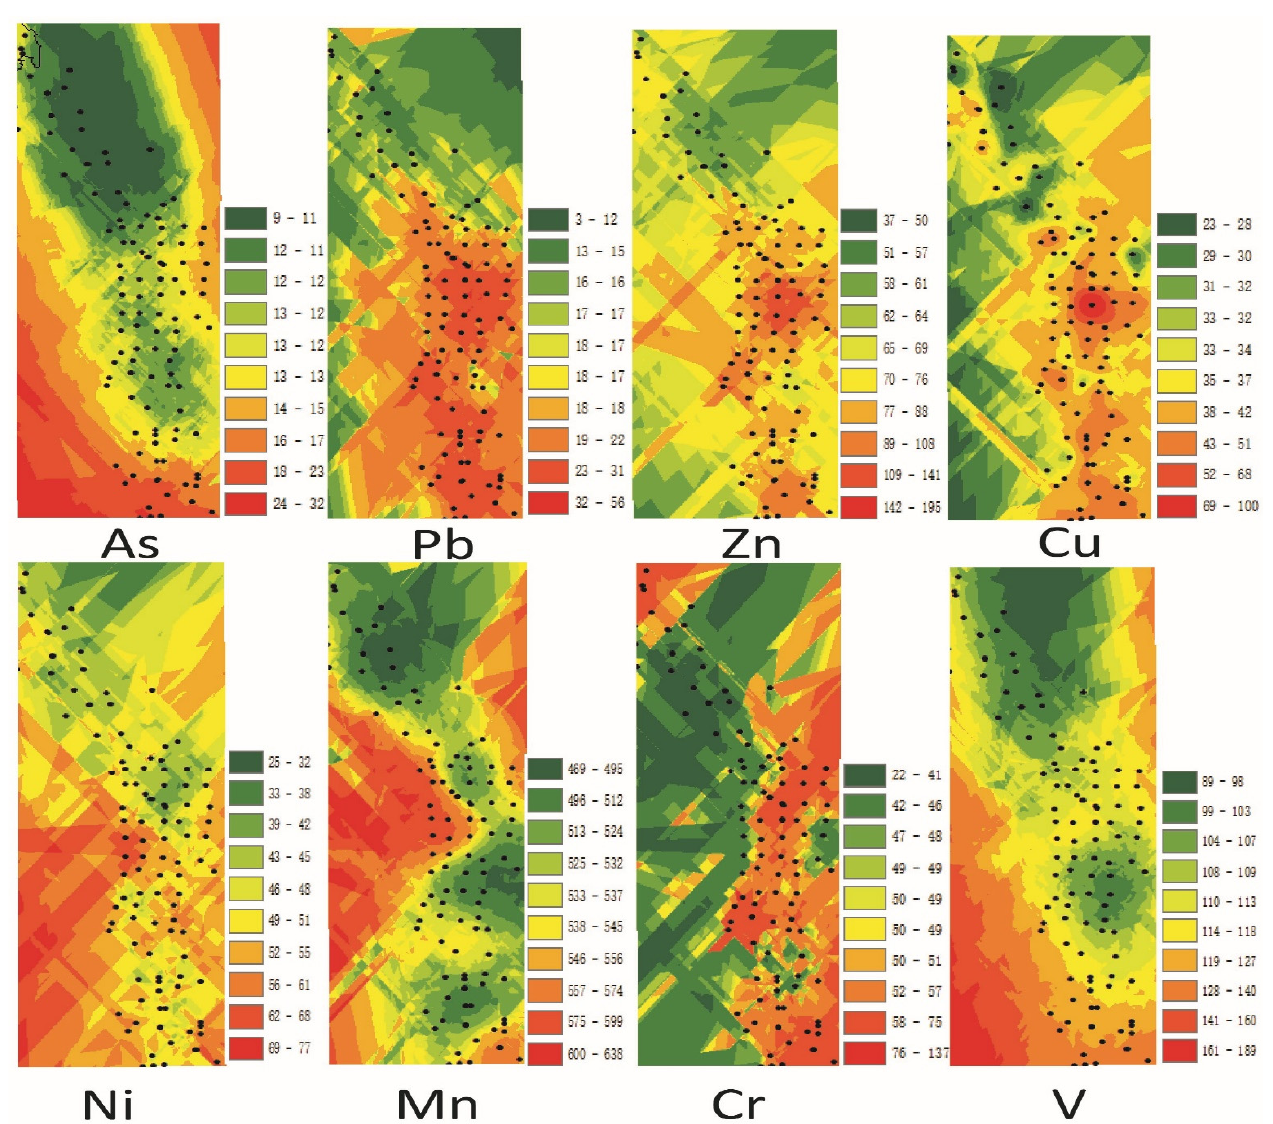
Figure 4. Distribution of heavy metal concentration in 0–20 cm soil layer.